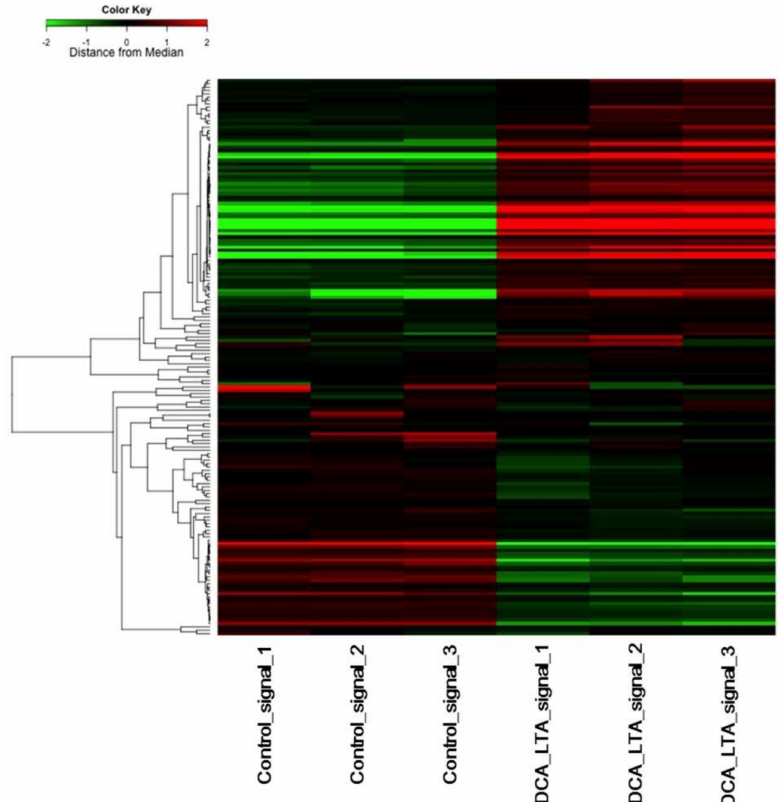
Figure 2. Clustering diagram of gene trees and heatmap of the tumor necrosis factor (TNF) signaling pathway generated using the MeV software. LX-2 cells were cultured in Dulbecco’s modified Eagle’s medium (DMEM) with or without 300 µ M deoxycholic acid (DCA) and 25 µ g/mL lipoteichoic acid (LTA) for 48 h in triplicate. We used the hierarchical clustering method to sort the genes (the distance metric was “Pearson correlation” and the linkage method was “average linkage clustering”). Rows represent the genes, and columns represent the samples. Colors indicate the distance from the median of each row. Red and green blocks represent genes whose expression levels were higher or lower than in the control,